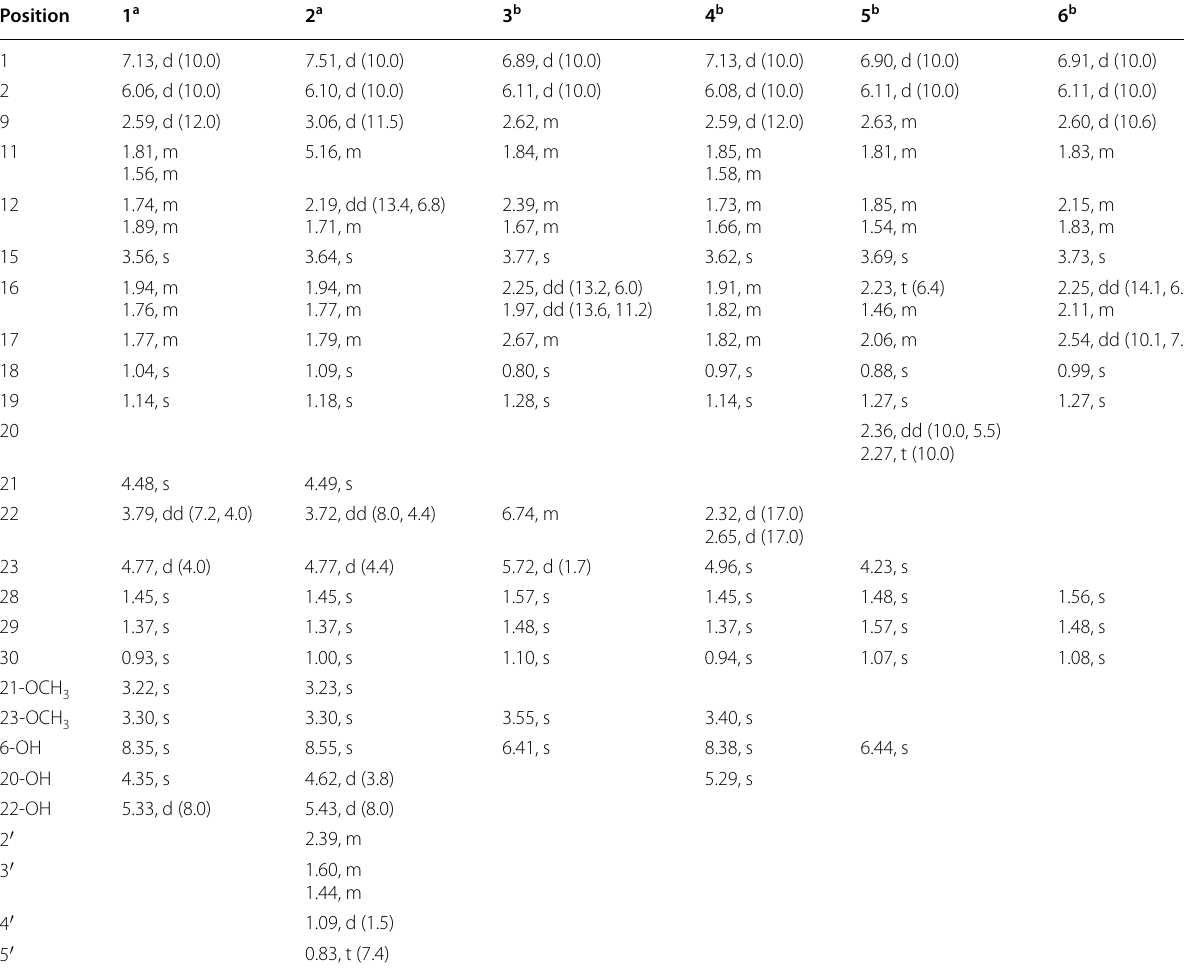
Table 1 1 H NMR spectroscopic data for 1 –